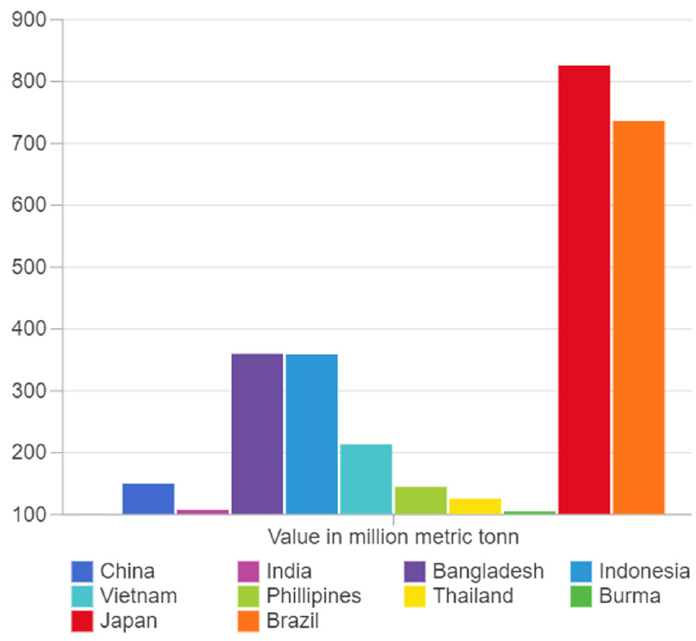
Figure 1. Country-wise (top ten) consumption of rice.